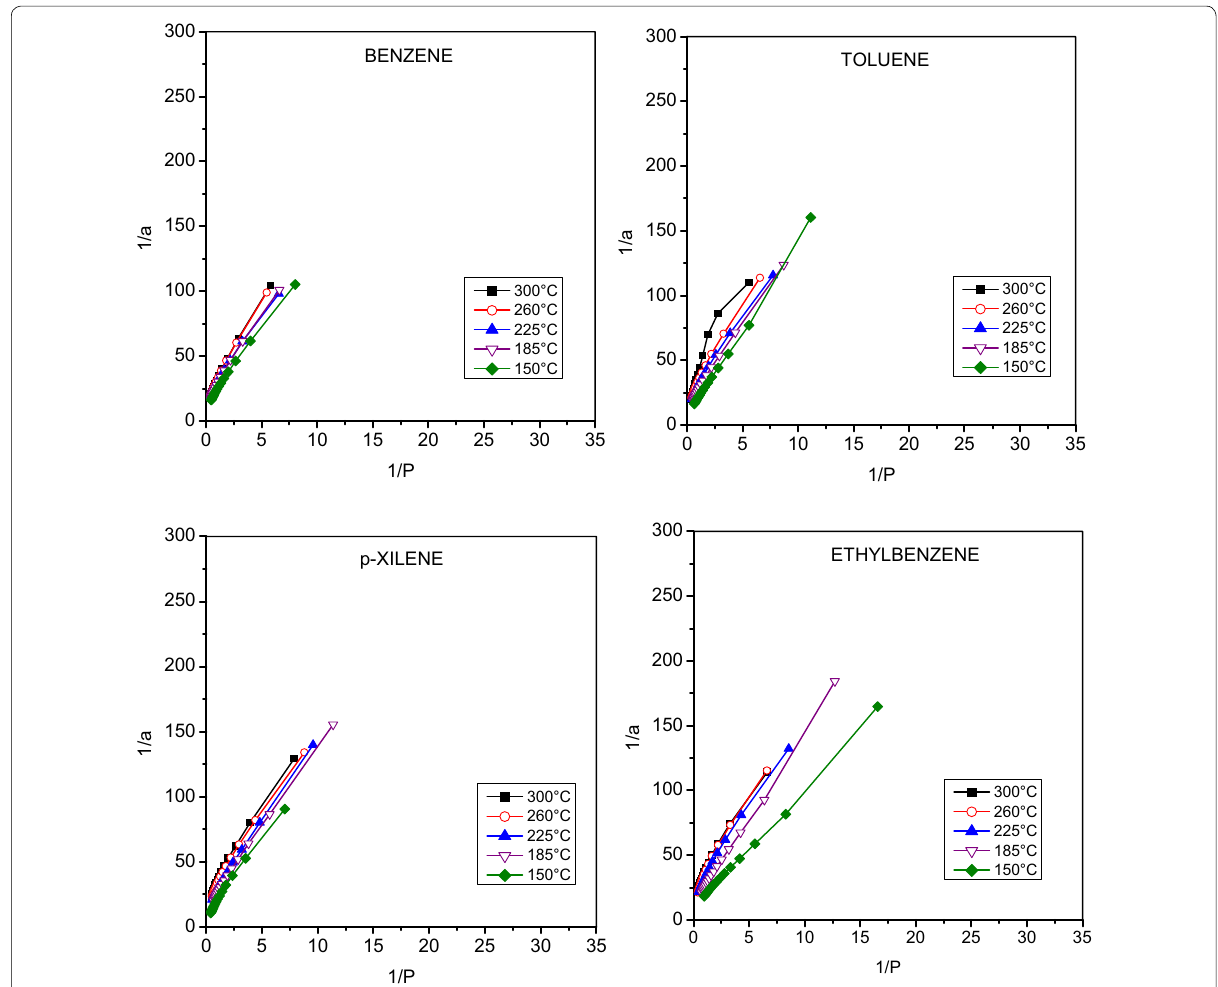
Fig. 11 Benzene, toluene, p ‑xylene, and ethylbenzene adsorption isotherms with the Langmuir model for SBA‑15/HT